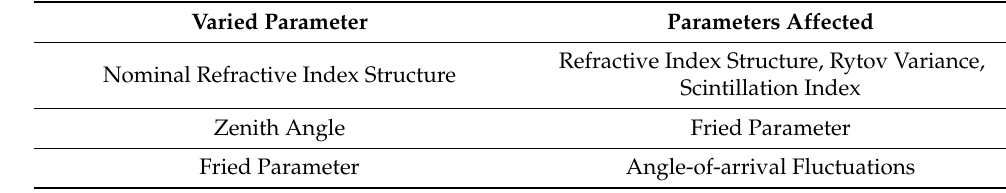
Table 2. Varied parameters and the parameters